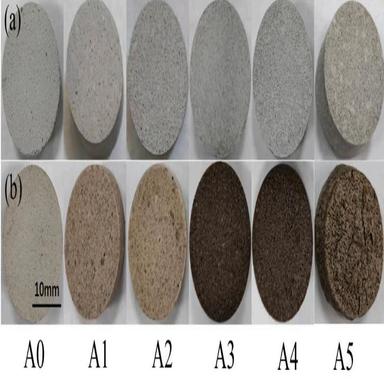
Photographs of ss-CPCM with different ratios of SSM (a) before and (b) after sintering.